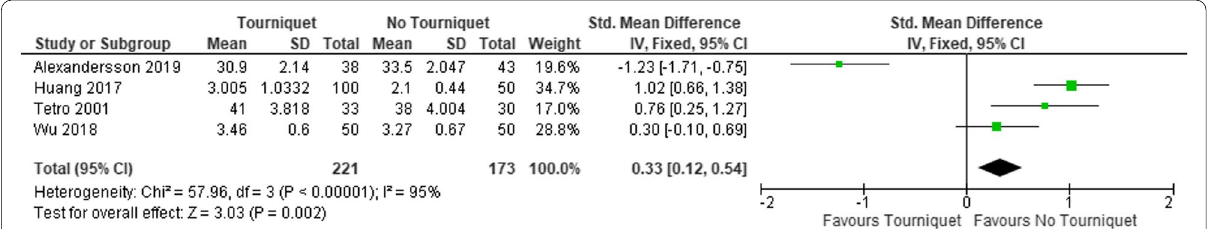
Fig. 5 Post op HB drop between the two